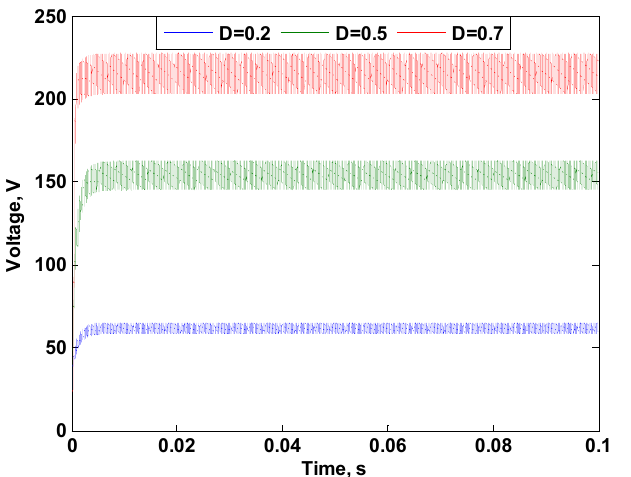
Figure 7. Output voltage at the output terminals of the studied converter at different duty ratios.